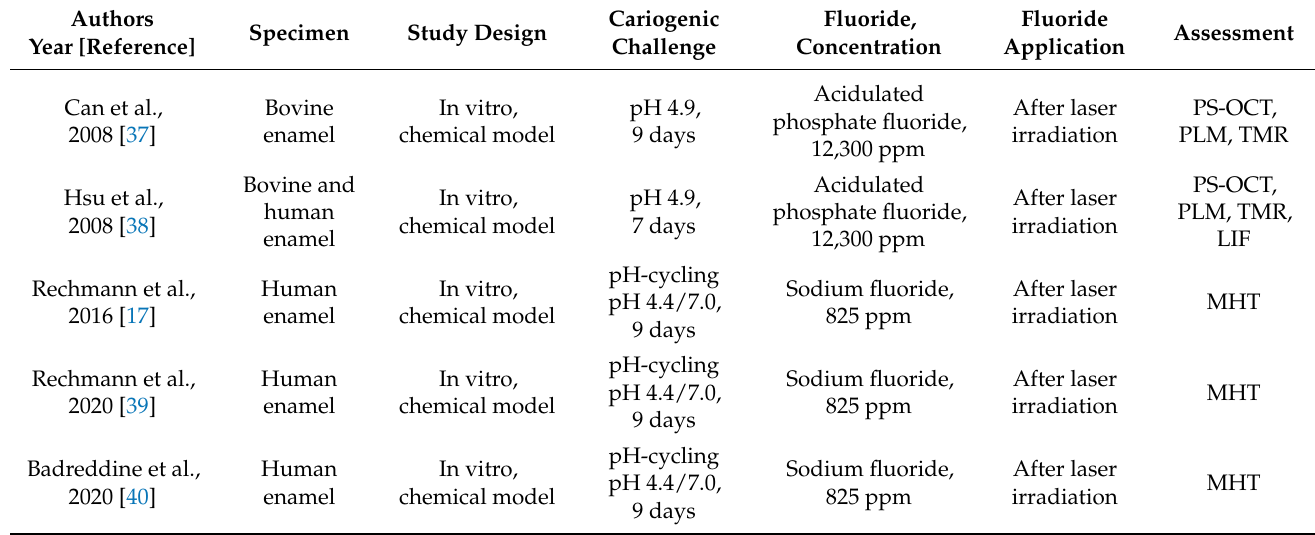
Table 2. Study design of the included studies in the systematic